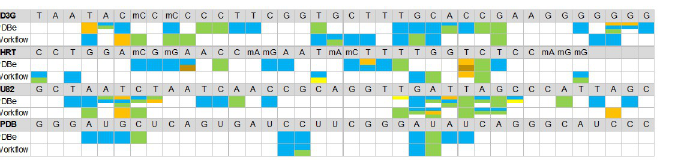
Fig 4. Identification of aptamer-target contact nucleotides and type of non-covalent interaction involved in the stabilization of the complexes for in silico (workflow) and experimental data (PDBe) docking. Hydrophobic Interactions (orange), Hydrogen Bonds (blue), Salt Bridges (green), π -Stacking (brown) and π -Cation Interactions (yellow).